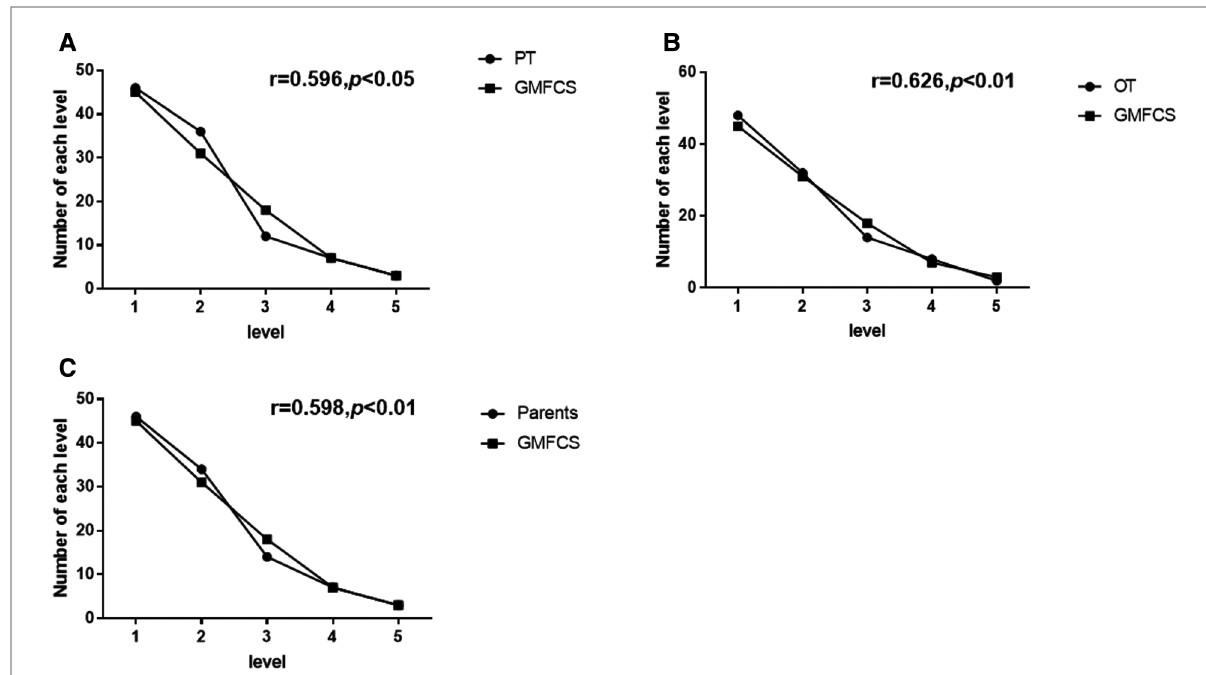
FIGURE 2 Correlation between the Mini-Manual Ability Classi fi cation System (Mini-MACS) and Gross Motor Function Classi fi cation System (GMFCS) levels. ( A ) Correlation between GMFCS and Mini-MACS used by the physical therapist (PT). ( B ) Correlation between GMFCS and Mini-MACS used by the occupational therapist (OT). ( C ) Correlation between GMFCS and Mini-MACS used by